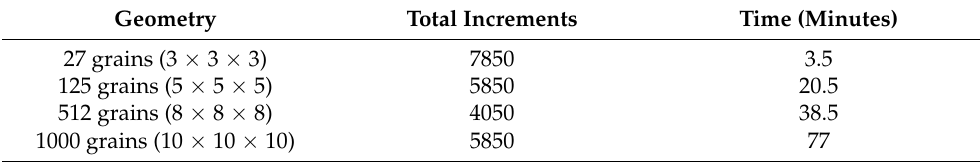
Table 3. Chemical composition and the SFE of the tested cast X8CrMnNi16-6-6 Steel.